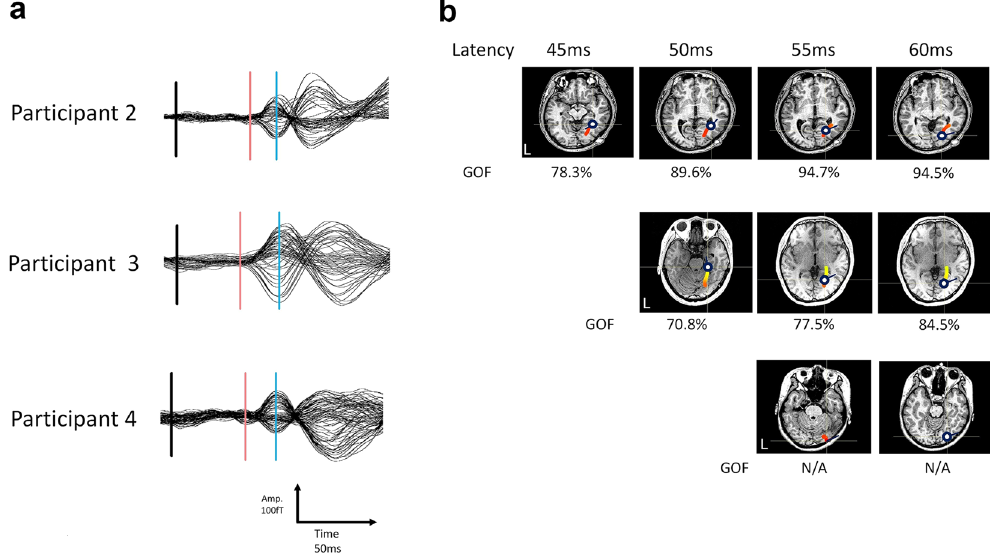
Figure 3. Averaged waveforms and the moving ECDs at 45–60 ms for the other three participants. ( a ) Averaged waveforms. Red lines indicate P45m, and blue lines indicate N75m as described in Fig. 2. Participant 3 did not clearly exhibit a P45m component, and we analysed the signals between 50 ms and 60 ms. ( b ) Estimated ECDs superimposed onto the horizontal plane of the MRI scan of each participant. Changes in the locations of the ECDs were calculated successively in 0.1-ms steps from 45 ms (participant 2), 50 ms (participant 3), and 55 ms (participant 3) to 60 ms after the presentation of the visual stimuli. Note that the GOF values were obtained from two participants and were between 70 and 95%. An axial coloured bar with a colour gradation from light yellow to red corresponds to the time course of the 45- to 60-ms continuum. In participants 2 and 3, the moving ECDs that were continuously estimated were localized first in the vicinity of the LGN and then moved along the optic radiation to the contralateral visual